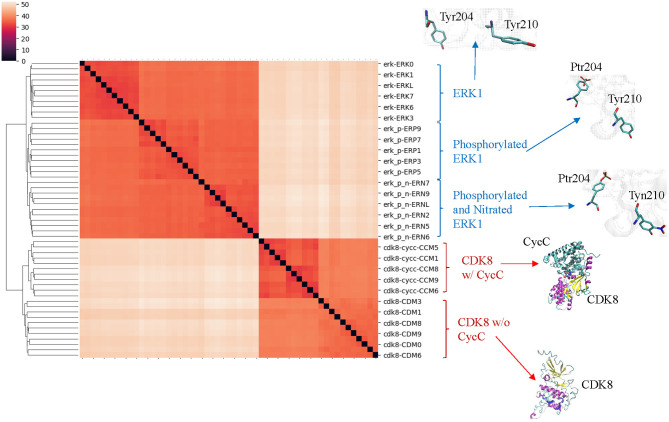
The clusters of ERK1 and CDK8 structures extracted from the MD simulations using our TSR-based structural comparison method match with their functional classifications. Phosphorylation site of ERK1 is at Tyr204, and phosphorylated Tyr204 is named as Ptr204. Nitration of ERK1 occurs at Tyr210, and nitrated Tyr210 is named as Tyn210. The amino acids with and without post-translational modifications at positions 204 and 210 of ERK1 are shown. The representative CDK8 structures with and without its partner CycC are shown. The dissimilarity values are indicated in the upper left corner in the clustering heatmaps.